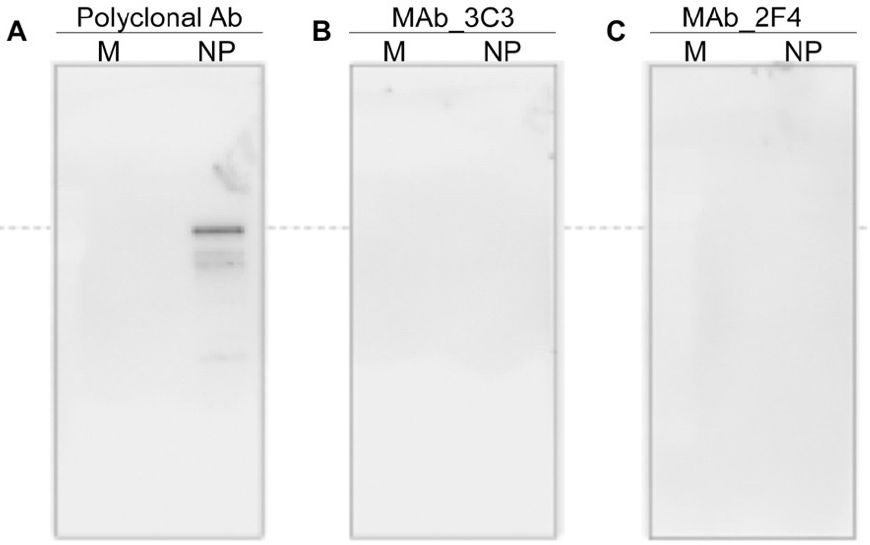
Figure 4. Western blot analysis to show the ineffectiveness of screening of MAbs through indirect ELISA. ( A ) Treated with polyclonal Ab against NP, ( B , C ) treated with MAbs.